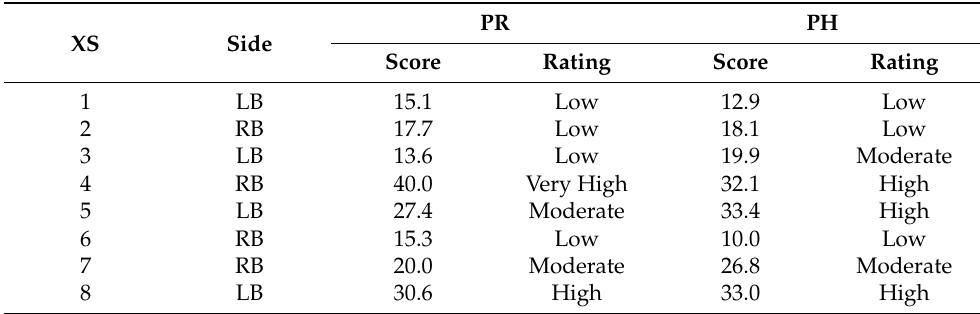
Table 3. Bank Erosion Hazard Index (BEHI) scores and ratings at the chosen cross-section for the Post-Restoration (PR) and Post-Hurricane (PH) geometries.